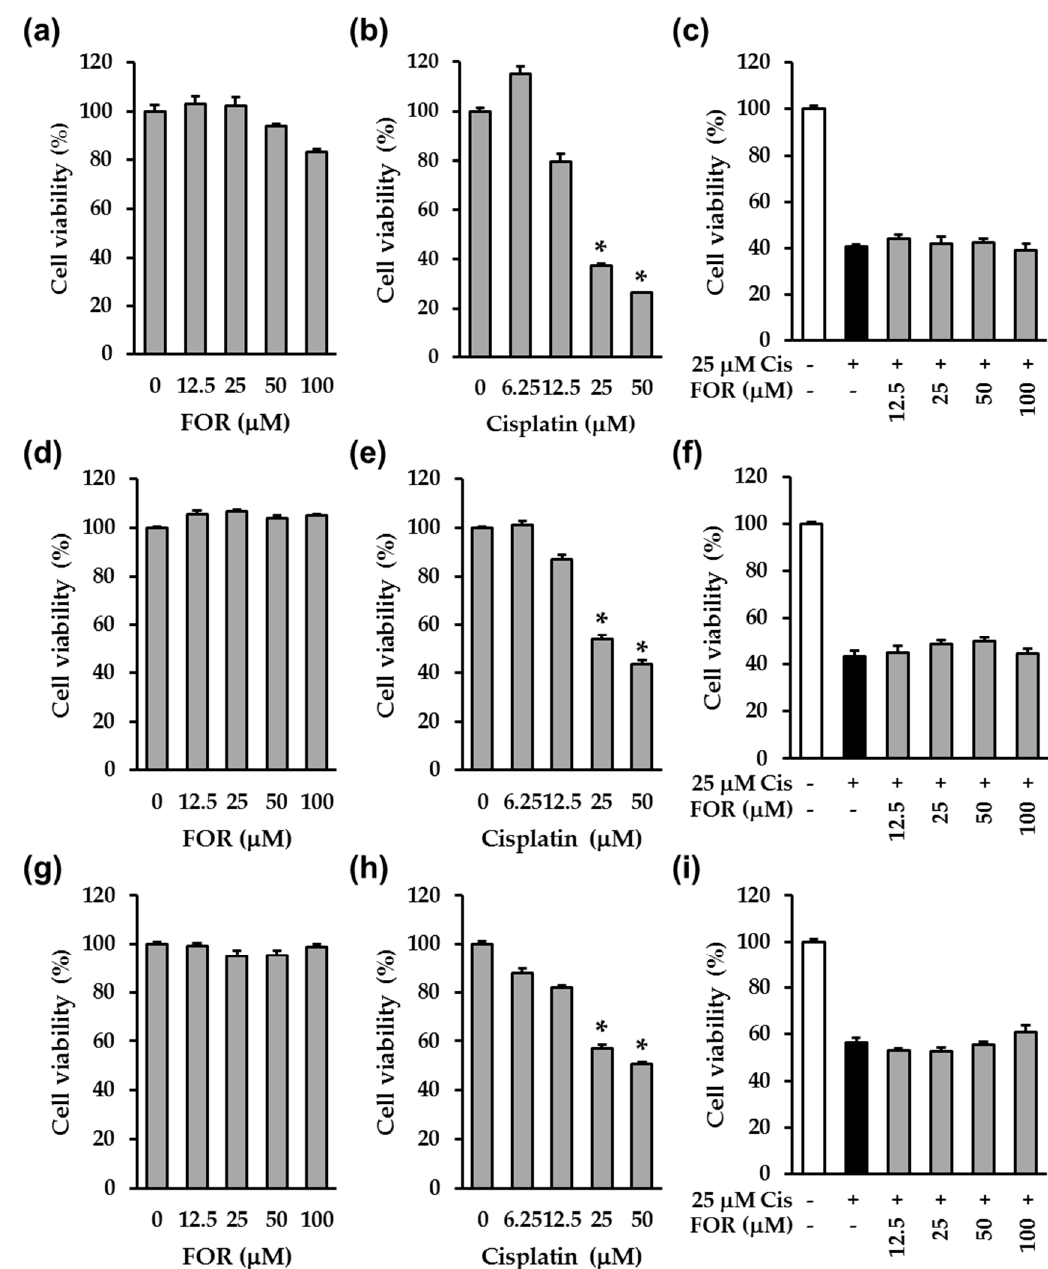
Figure 3. Formononetin had no effect on the anticancer effect of cisplatin in cervical cancer cells. ( a – c ) HeLa cells were exposed to formononetin ( a ), cisplatin ( b ), or formononetin with 25 μ M cisplatin ( c ) for 24 h. ( d , f ) SaHa cells were exposed to formononetin ( d ), cisplatin ( e ), or formononetin with 25 μ M cisplatin ( f ) for 24 h. ( g – i ) CaSKi cells were exposed to formononetin ( g ), cisplatin ( h ), or formononetin with 25 μ M cisplatin ( i ) for 24 h. Bars denote the percentage of cell viability (mean ± S.E.M., * p < 0.05 compared with control cells).